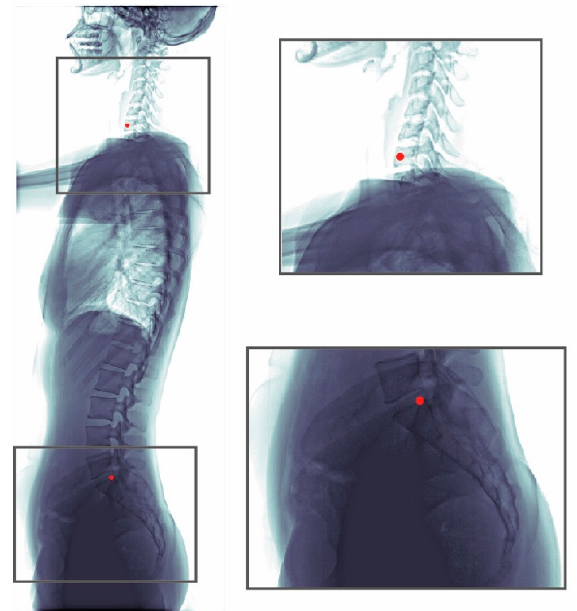
Figure 1. Annotations of a radiograph. The C7 center and the posterior corner of the sacrum were annotated (red dots).